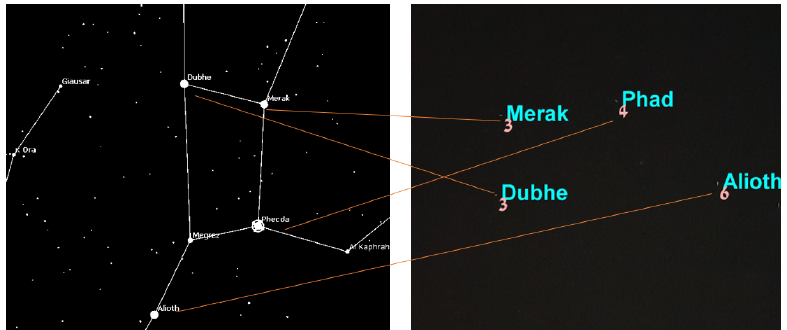
Figure 15. The algorithm implementation on Samsung’s Galaxy S 7, S 8, S 9 smartphones. The right figure is the frame of the big bear constellation with star identification. The the left figure is the DB simulation of the big bear constellation as presented in the stellarium